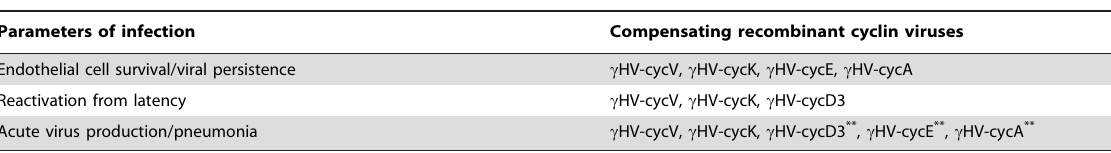
Table 1. Cyclin-dependent parameters of infection and genetic complementation.